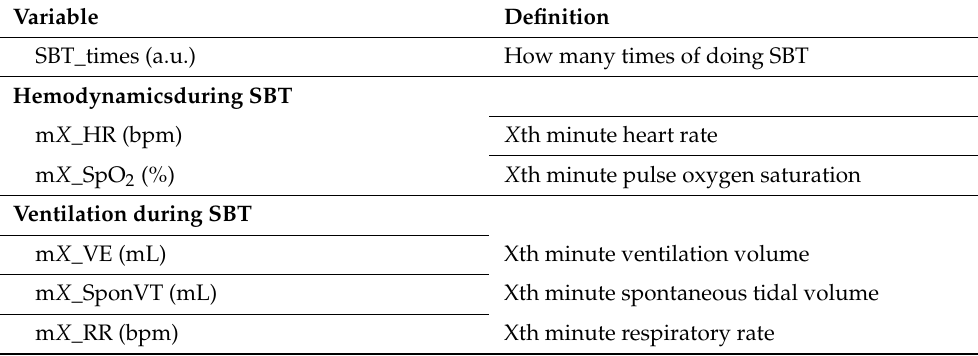
Table 2. SBT-related cardiovascular and respiratory